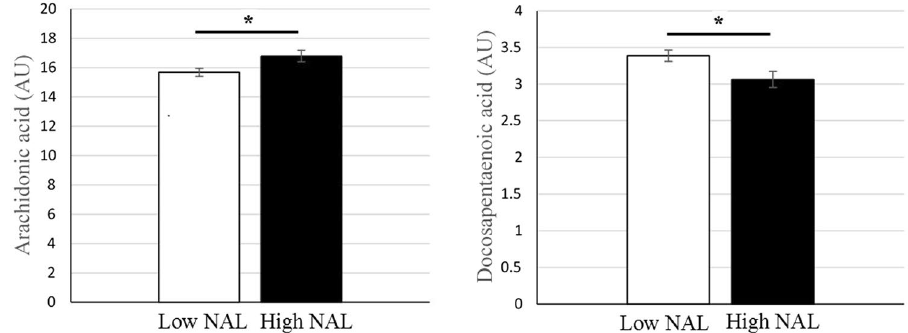
Figure 1. Altered fatty acid levels in cognitively normal individuals with low and high NAL. Elevated erythrocyte arachidonic acid levels and decreased docosapentaenoic acid (n-3) levels were observed in individuals with high NAL (N = 35) compared to those with low NAL (N = 65), based on standard uptake value ratio cut off score of 1.35. Fatty acid concentrations were measured in arbitrary units (AU). ‘ * ’ represents p < 0.05, adjusted for covariates age, gender, years of education and APOE ε 4 status; NAL: neocortical amyloid load measured via positron emission tomography, using ligand 18 F-Florbetaben. The error bars represent